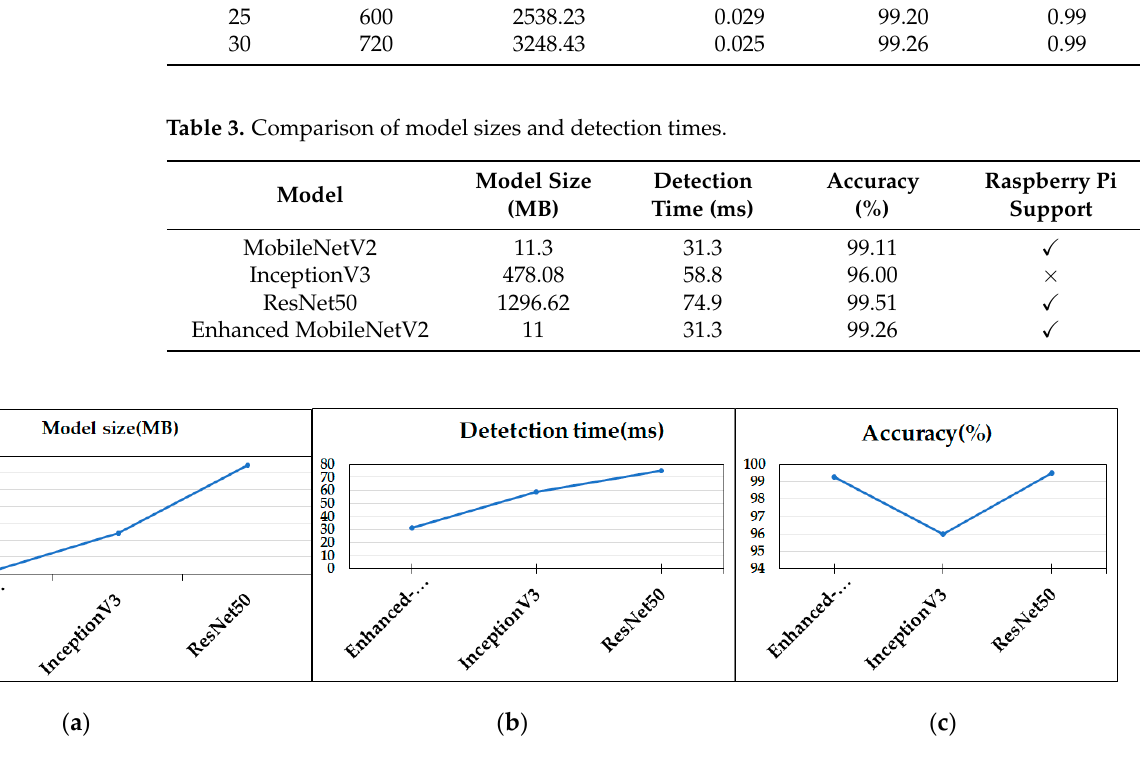
Table 3. Comparison of model sizes and detection times.